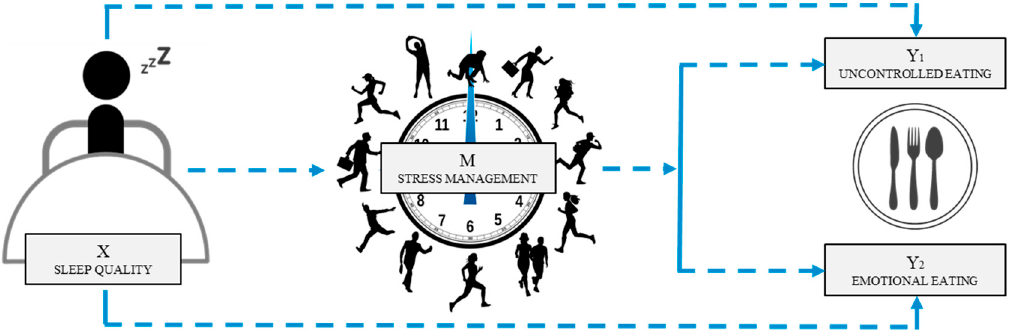
Figure 1. Diagram with the hypothesized relation between the variables.